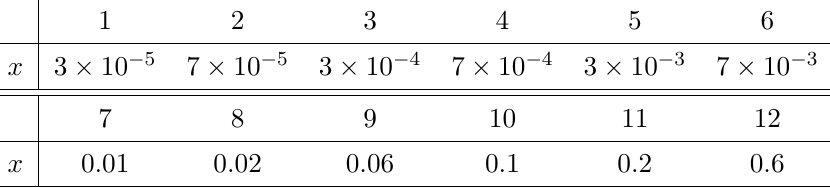
Relative unc. of f i ( x 1 , Q )/ f j ( x 2 , Q ) by LM at 90% CL Q = 1.295 GeV